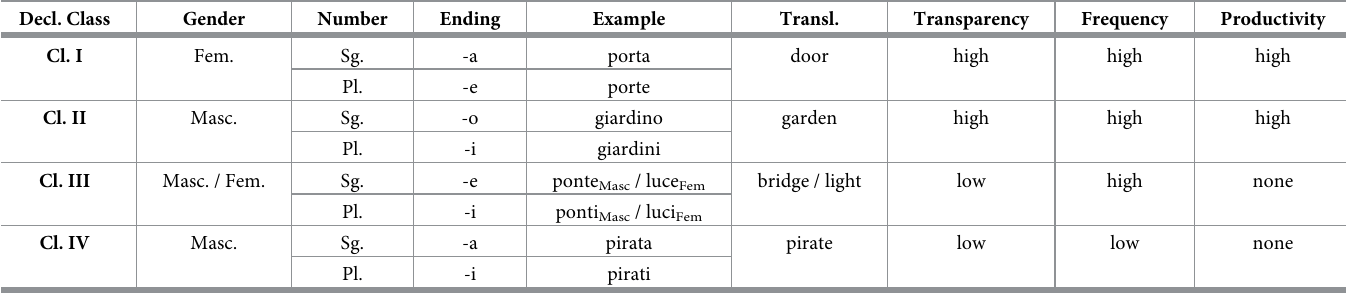
Table 1. Italian noun declension